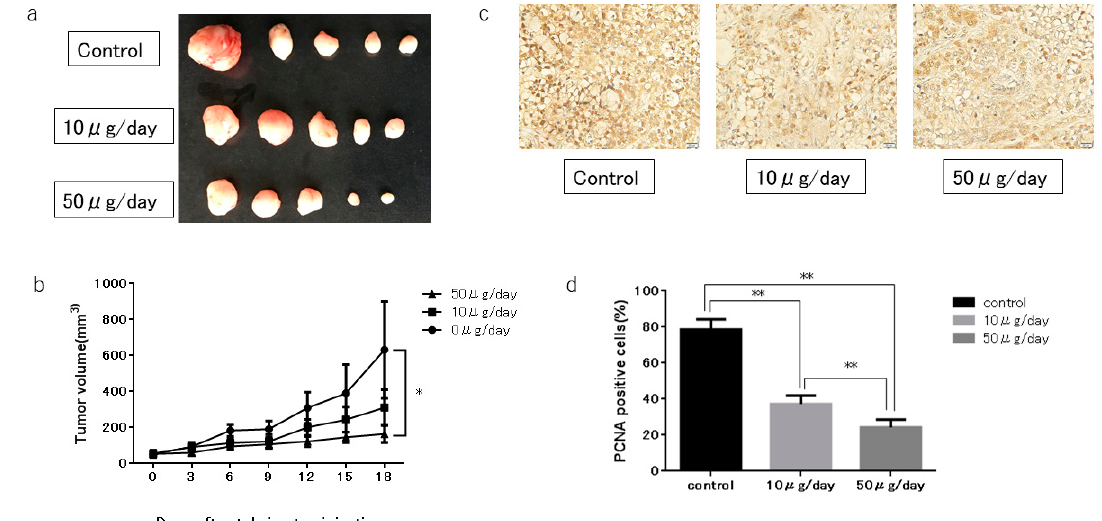
Figure 8. KYSE180 tumors in nude mice treated with telmisartan. ( a ) Representative images of gross KYSE180 tumors treated with telmisartan (10 µg/day or 50 µg/day), or the control. ( b ) Growth curves of xenografts showing mean tumor volume of control and telmisartan at 10 µg/day or 50 µg/day). Tumors were significantly smaller in the high-dose (50 µg/day) group than in the control group. ( c ) Immunohistochemistry examination using PCNA staining (400× magnification). ( d ) Quantitative comparison of PCNA+ cells of the control, low-dose (10 µg/day) and high-dose (50 µg/day) groups. PCNA+ cells and total numbers of cells were counted from 5 fields (400× magnification). Percentages of PCNA+ cells were significantly smaller in low-dose and high-dose telmisartan treated groups than in the control group. * p < 0.05; ** p < 0.01.